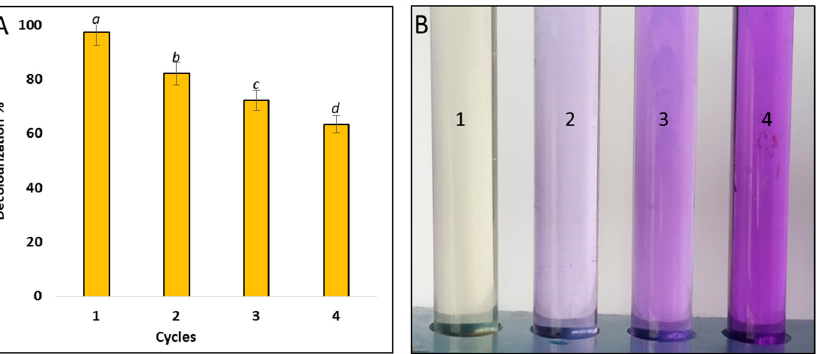
Figure 8. Hem-NP recycling in the crystal violet dye removal process ( A ) and crystal violet dye removal cycle color changes ( B ) at 4 cycles (1–4). Superscript letters from a to d reveal the power of significance.